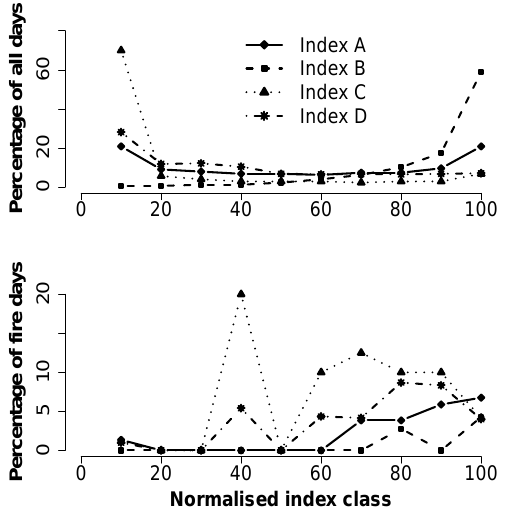
Fig. 5. Robust regression of ranked percentiles.